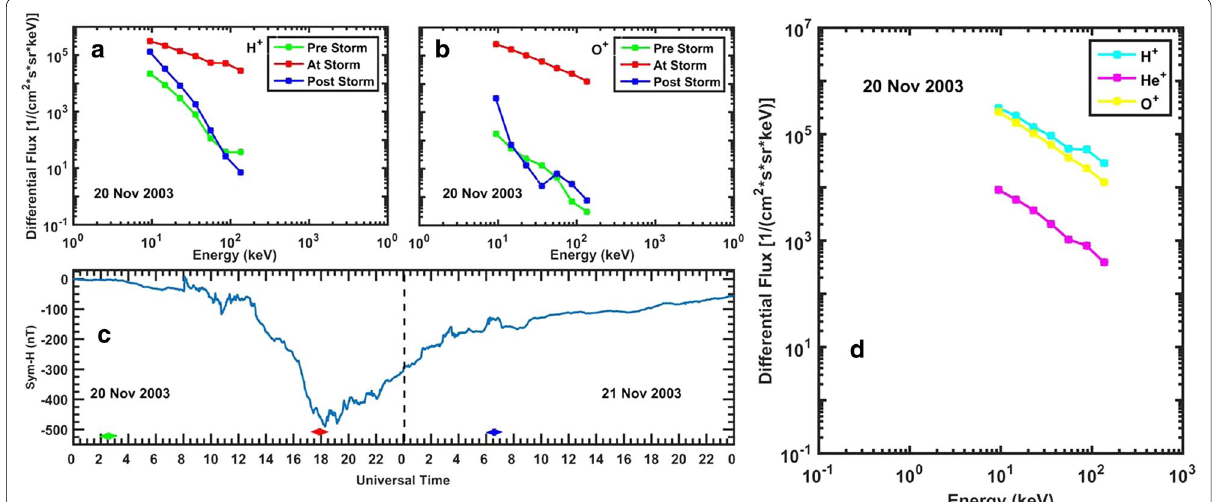
Fig. 4 Differential flux measured using Geotail satellite, at different energies for 20–21 November 2003 at different phase of the storm for a H + and b O + c the corresponding time interval for pre-storm (green (0200–0400 UT), post-storm (blue (0600–0700 UT)) and main phase (red (1720–1820 UT)) is shown with the progress of geomagnetic storm d differential flux change with respect to energy at main phase of the storm for H + , He +